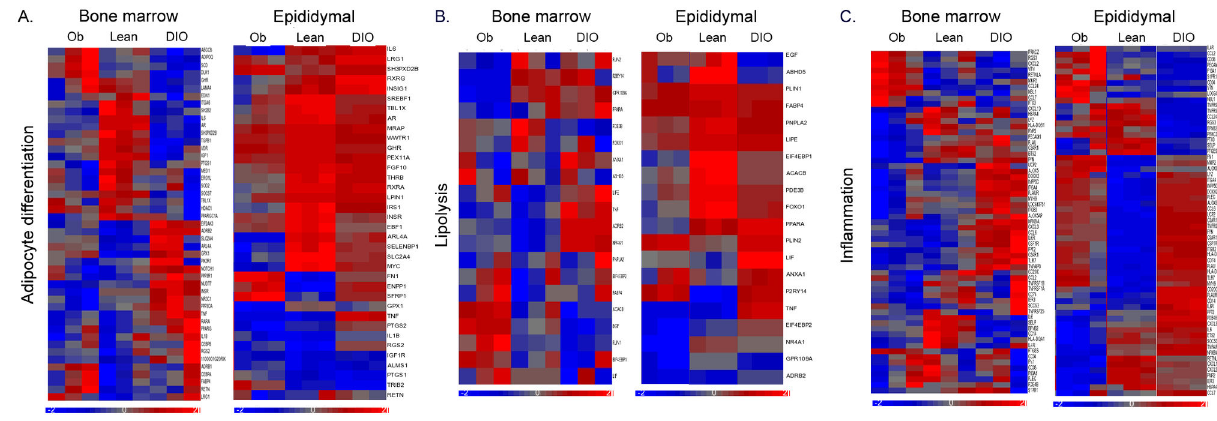
Figure 4. Heat maps of adipocyte-specific gene expression in bone marrow and epididymal adipocytes in 6-month-old diet-induced obese and ob/ob mice. (a) Clustering of genes involved in adipocyte differentiation in 6-month old diet-induced obese (DIO) and ob/ob compared with standard chow fed lean mice in bone marrow (left) and epididymal (right) adipocytes. (b) Clustering of genes involved in lipolysis in 6-month old DIO and ob/ob mice compared with standard chow fed lean mice in bone marrow and epididymal adipocytes. (c) Clustering of genes involved in inflammation in 6-month old DIO and ob/ob mice compared with standard chow fed lean mice in bone marrow and epididymal